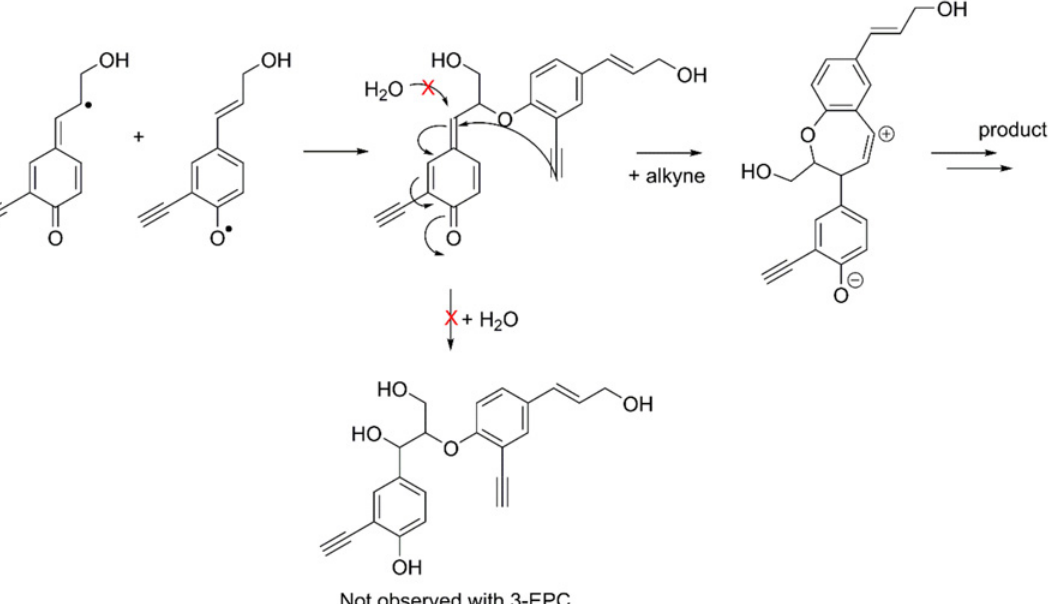
Fig 3. Proposed pathway for the formation of a novel β -ether linkage. For typical monolignols, external trapping of the β -ether quinone methide occurs via water addition (not experimentally observed with 3-EPC). The alternate pathway illustrates the proposed internal trapping of the quinone methide via the alkyne when 3-EPC is polymerized. The proposed carbocation would undergo additional reactions to yield an as-yet unidentified novel β -ether linkage